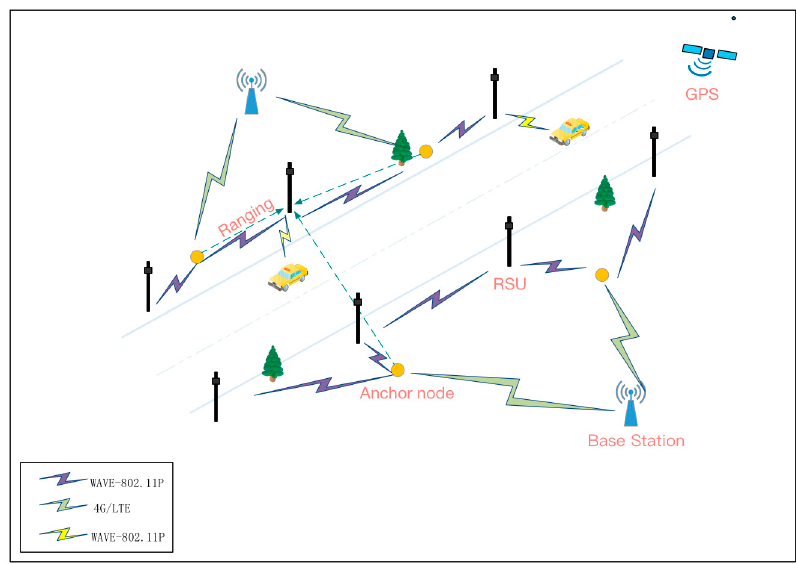
Figure 2. Network architecture in a desolate environment.